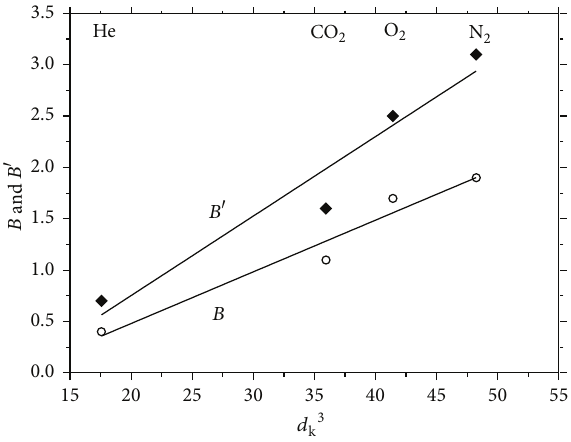
Figure 3: Dependence of 𝐵 and 𝐵 󸀠 parameters on gas molecule 3 volume ( 𝑑 k